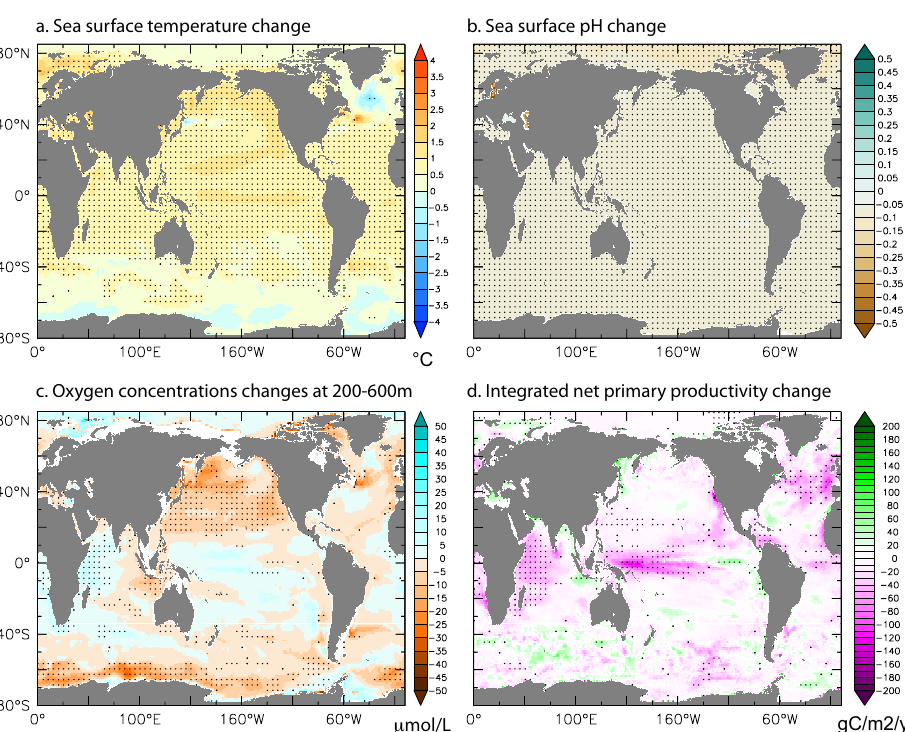
Fig. 6. Change in stressor intensity (defined as the change in the magnitude of the considered variable) in 2090–2099 relative to 1990– 1999 under RCP2.6. Multi-model mean of (a) sea surface warming ( ◦ C), (b) surface pH change (pH unit), (c) subsurface dissolved O 2 concentration change (averaged between 200 and 600m,mmolm − 3 ) , and (d) vertically integrated NPP (gCm − 2 yr − 1 ) . Stippling marks high robustness. Robustness is estimated from inter-model standard deviation for SST and pH, from agreement on sign of changes for O 2 and